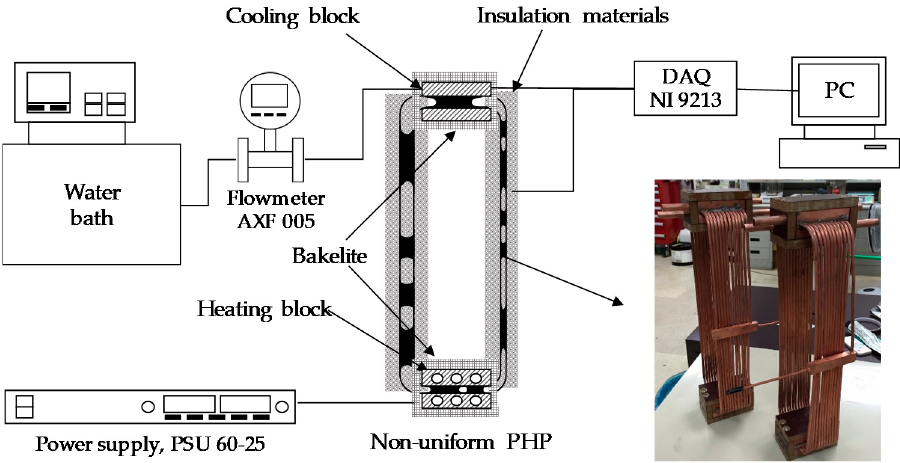
Figure 2. Experimental setup.